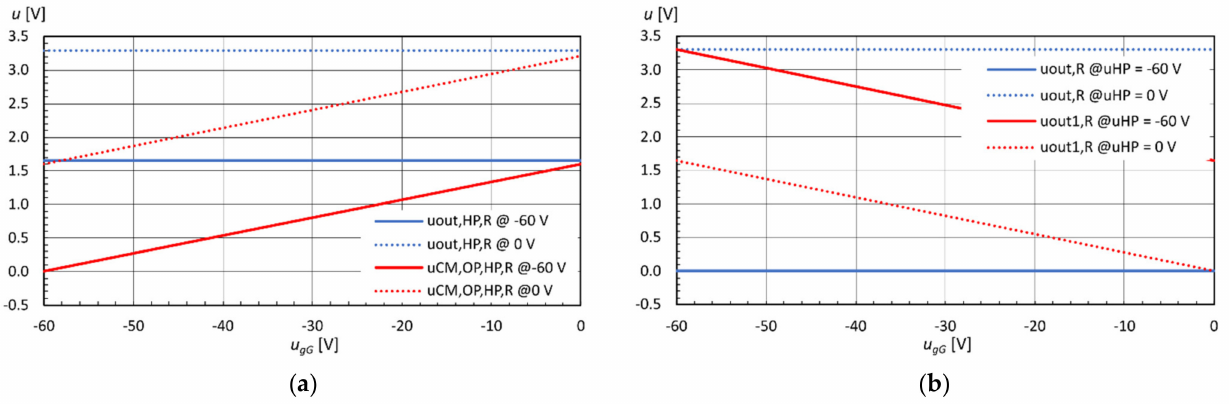
Figure 14. Characteristic voltages vs. u gG for the reversed u HP connection: ( a ) single-stage circuit; ( b ) two-stage